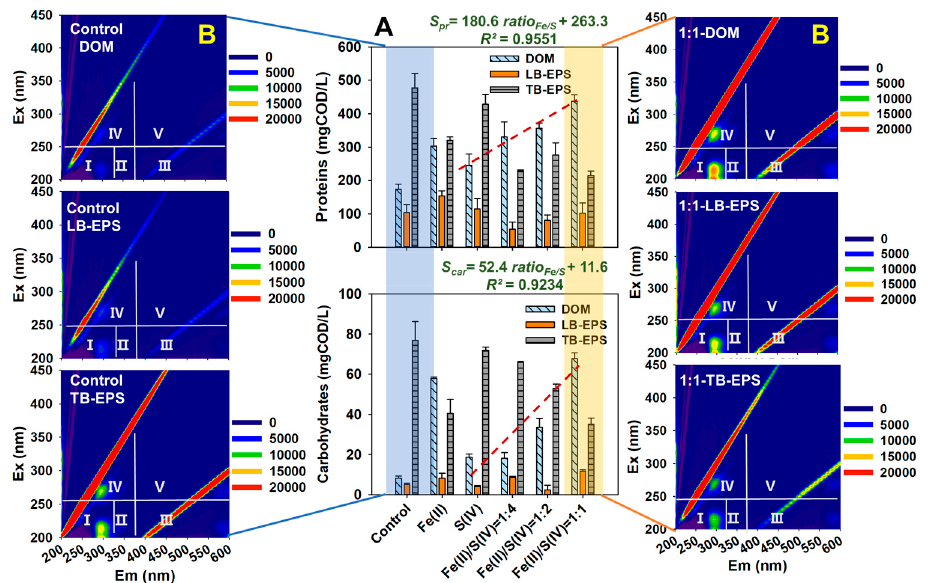
Figure 1. Changes in proteins and carbohydrates in the DOM, LB-EPS, and TB-EPS layers under different treatments of Fe 2+ /Na 2 SO 3 ( A ). 3D-EEM spectra of different layers in the RWAS and 1:1 Fe(II)/S(IV) tests ( B ).